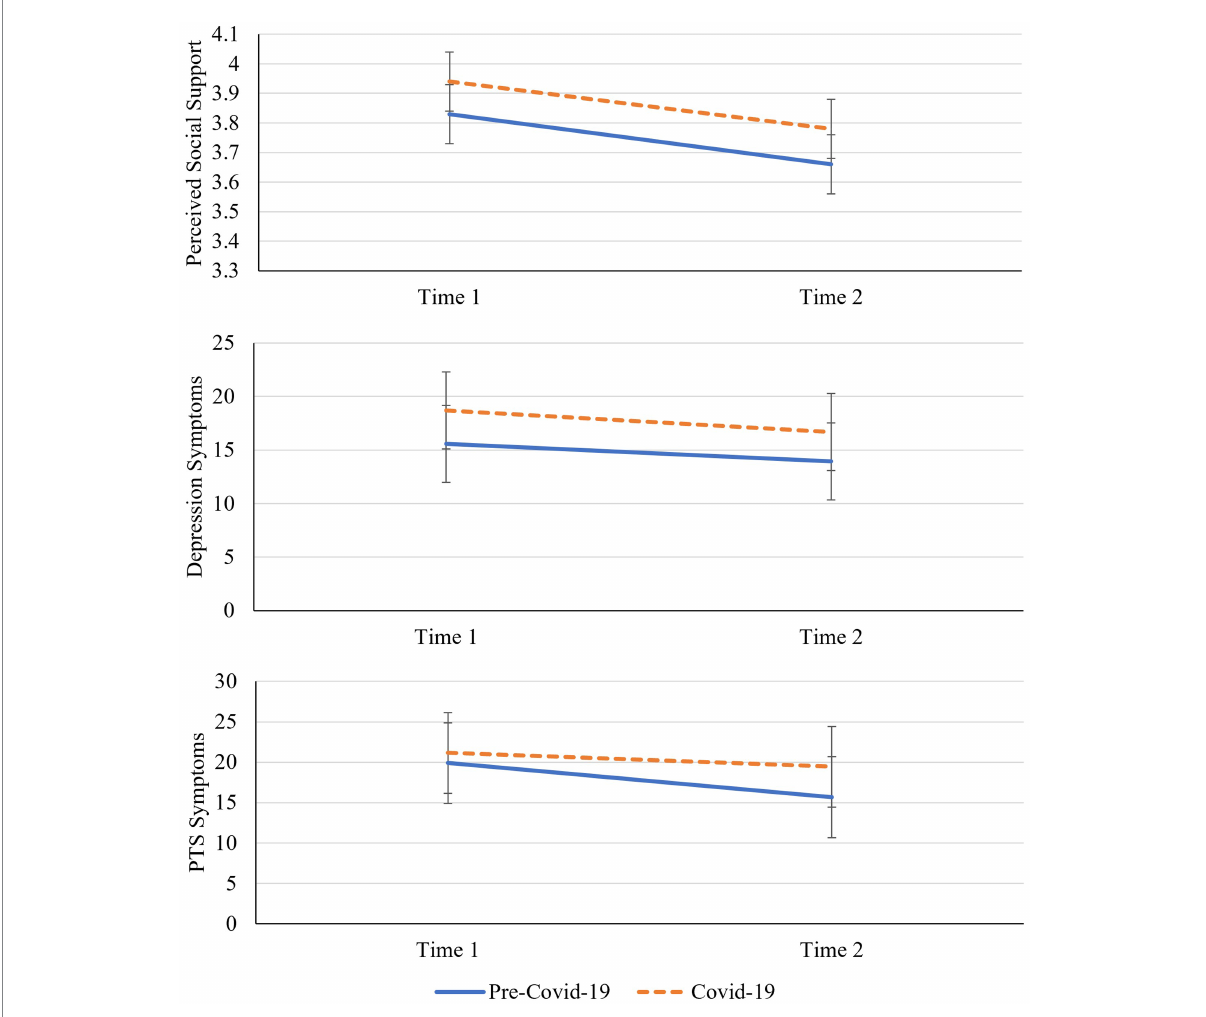
FIGURE 1 Longitudinal changes in perceived social support, depression and PTS symptoms by cohort. PTS symptoms denotes post-traumatic stress symptoms. Error bars = 95% confidence